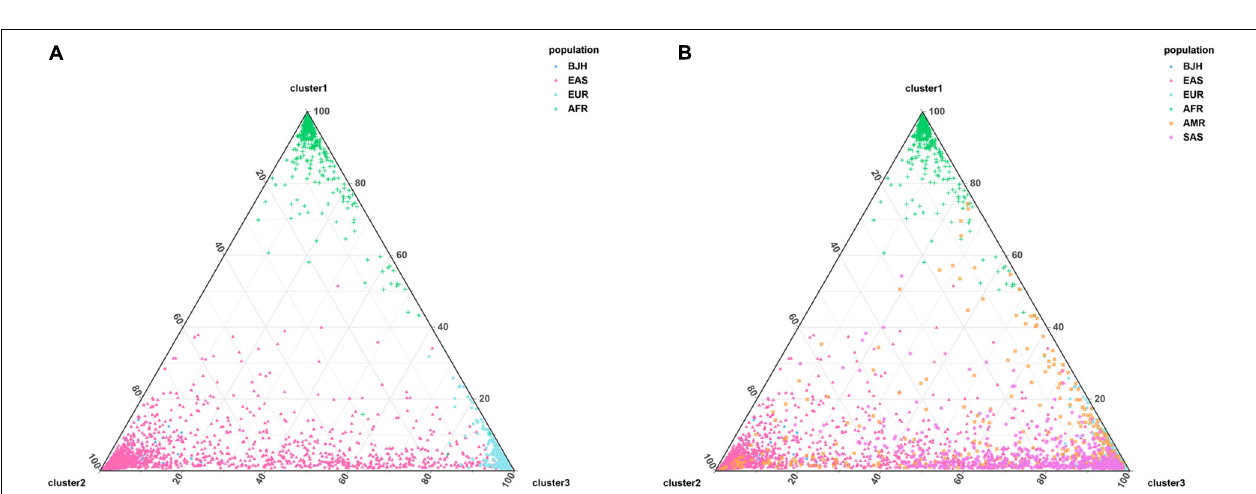
FIGURE 7 | Clustering analysis ( K = 3) on the individual level among the Beijing Han population and three continental populations (A) ; clustering analysis ( K = 3) on the individual level among the Beijing Han population and five continental populations